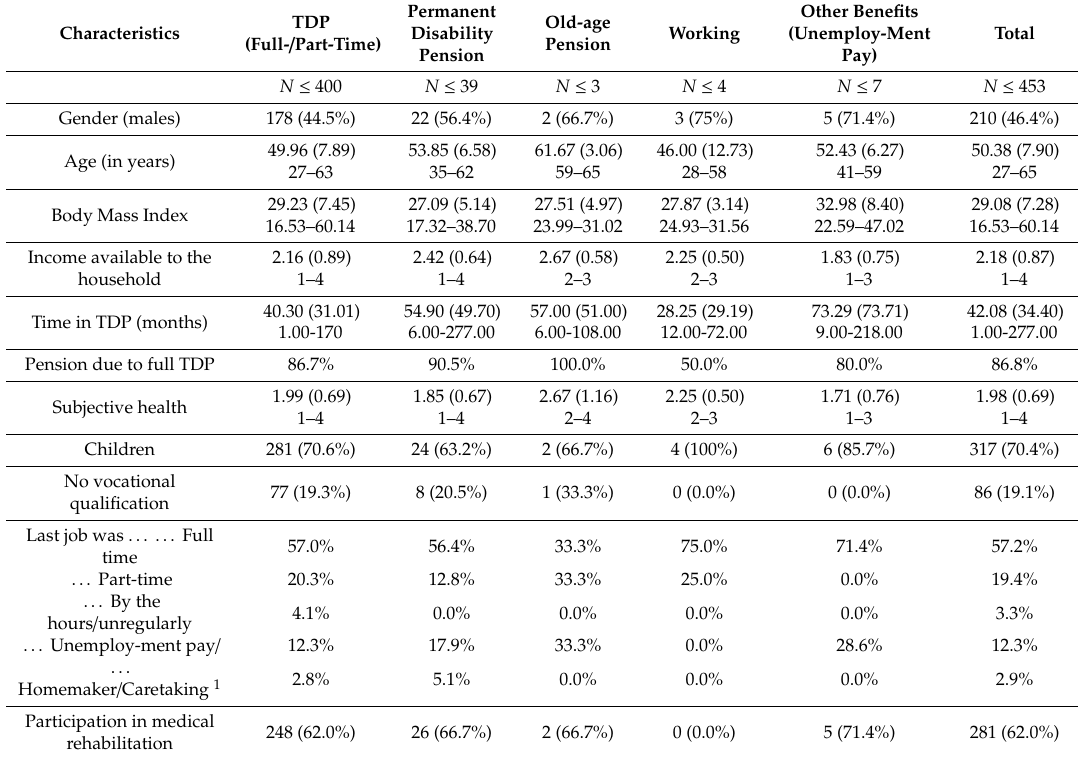
Table 2. Characteristics of return-to-work (RTW) status at T3 by variables at T1 (age, BMI, etc.): Mean values, standard deviation in brackets, range, or